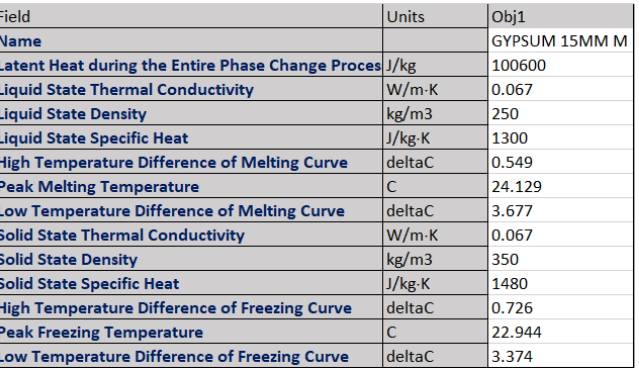
Figure A1. Data input for PCM material in EP following the hysteresis model [19]. Sources: density values [50], specific heat values and thermal conductivities [51]. All other values were obtained from own measurements. Table A1. Thermal properties of construction elements: office room [17]. Values obtained from Uba- kus online calculator [52].